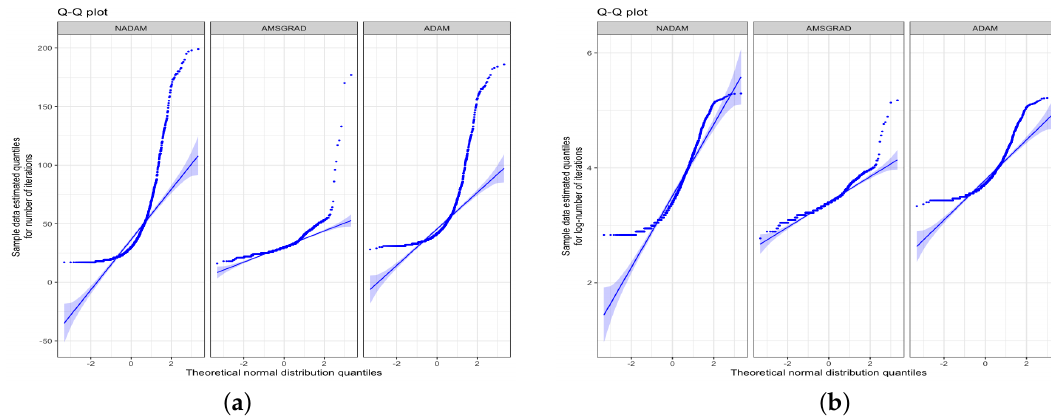
Figure 2. QQ-plot of speed of convergence and log of speed of convergence from left to right, for different optimizers.